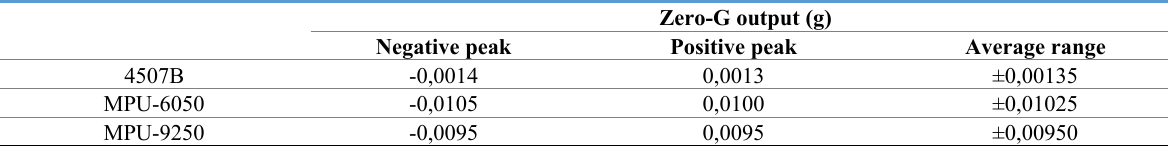
Table 2. Comparison of noise